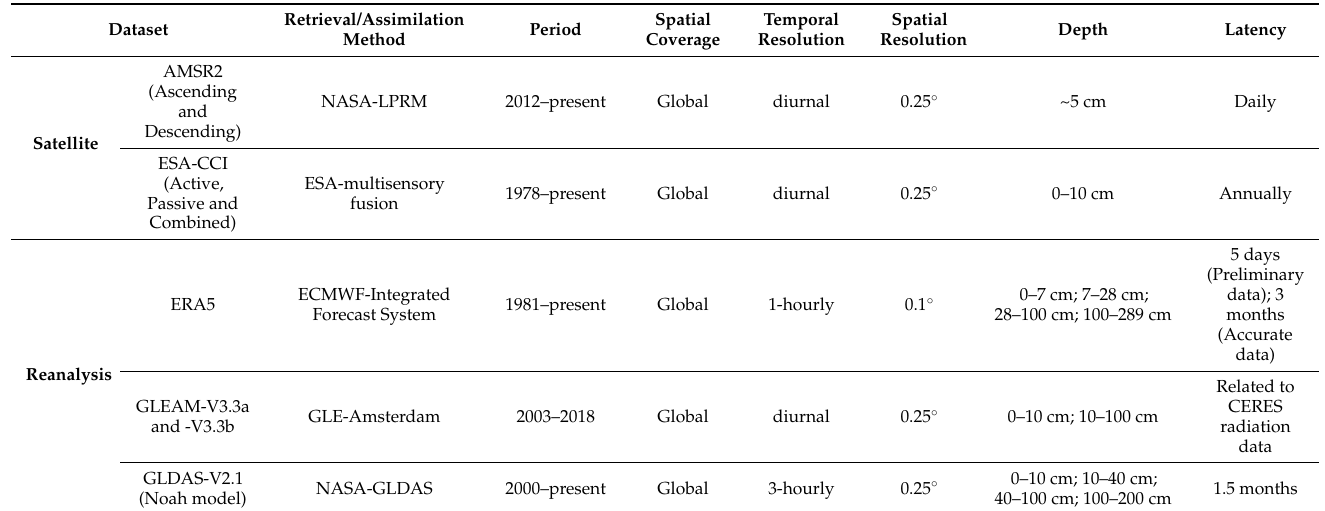
Table 1. Summary of satellite and reanalysis soil moisture